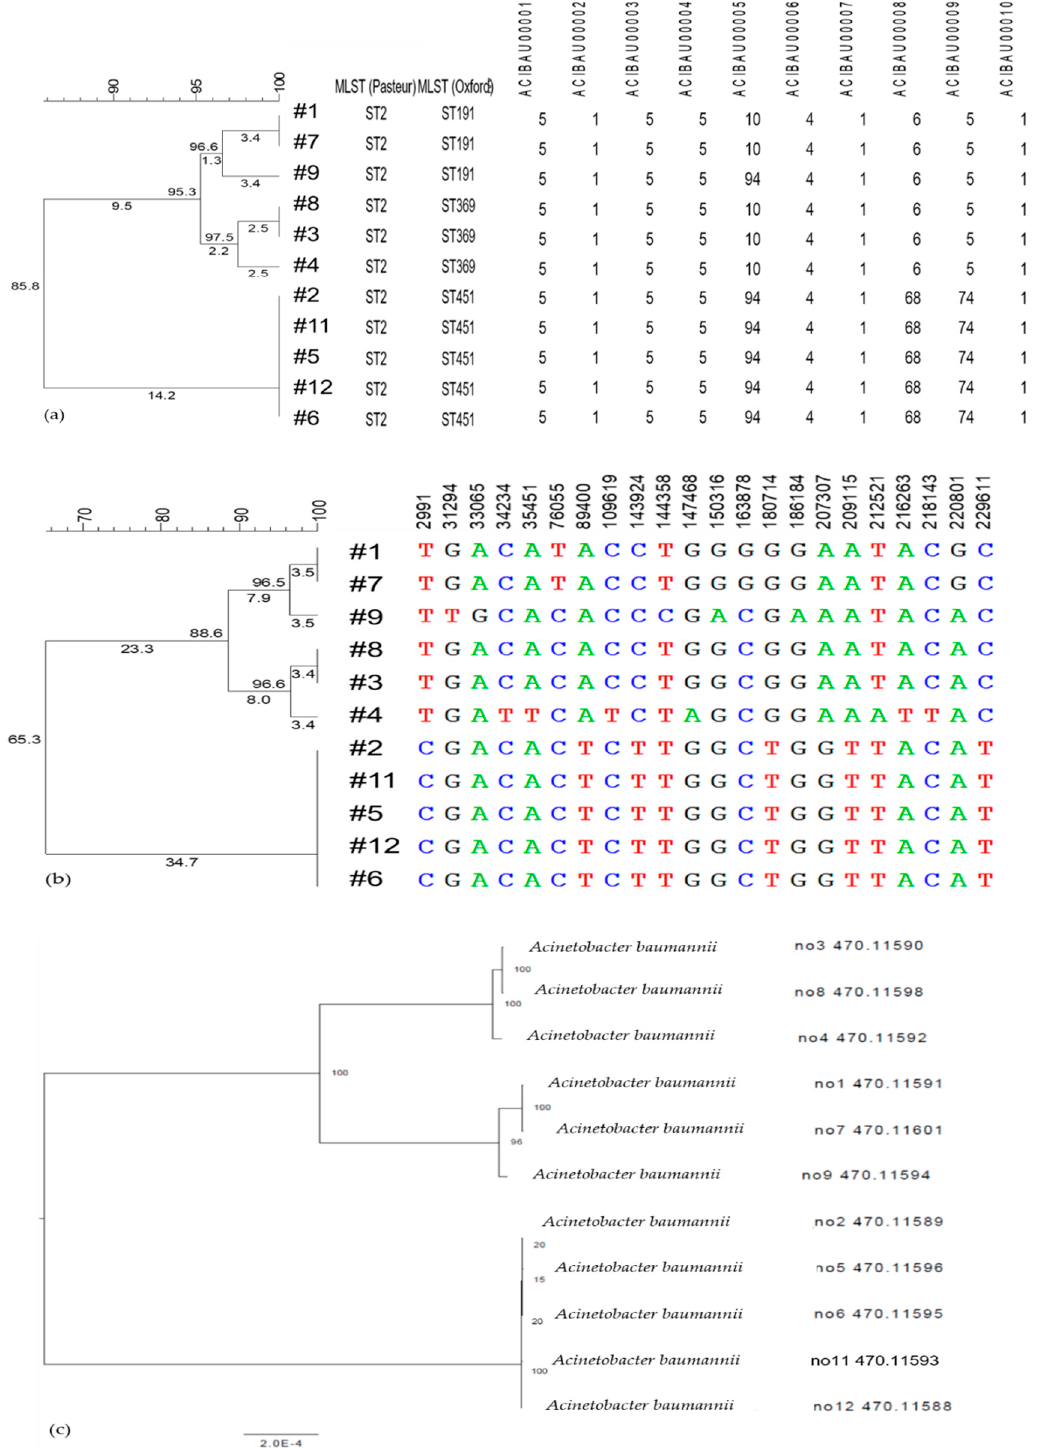
Figure 1. wgMLST and wgSNP, SNV dendrogram of 11 isolates: ( a ) wgMLST; ( b ) wgSNP by Bionumerics; and ( c ) SNV analysis by PATRIC. Not all the loci are shown in ( a , b ). Based on the cgMLST scheme with 2390 targets on Pathogenwatch, at the threshold of 10, isolates were clustered into three groups of #2, #6, #11, #12, and #5; #1 and #7; and